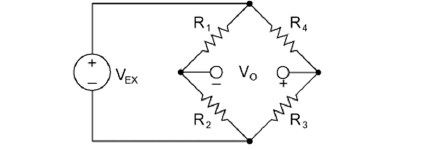
Figure 1. From left to right: ( a ) measured loads for which X = lateral force; Y = anterior force; Z = normal force; x = sagittal torque; y = frontal torque; z = transversal torque, ( b ) installed seat post.